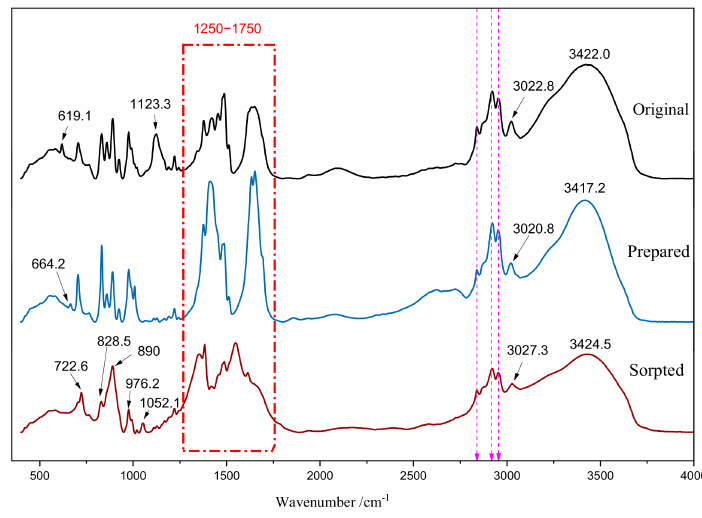
Figure 3. FTIR spectra of